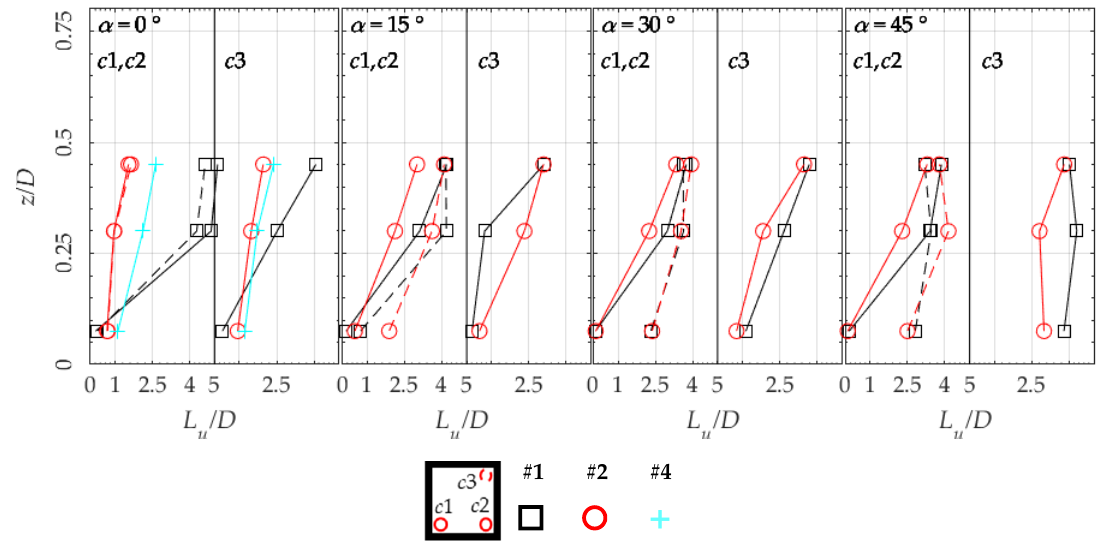
Figure 13. Longitudinal integral length scale of turbulence L u at windward ( c 1, c 2) and leeward ( c 3) corner locations. Symbols as indicated in the legend, for the four wind directions and configurations.